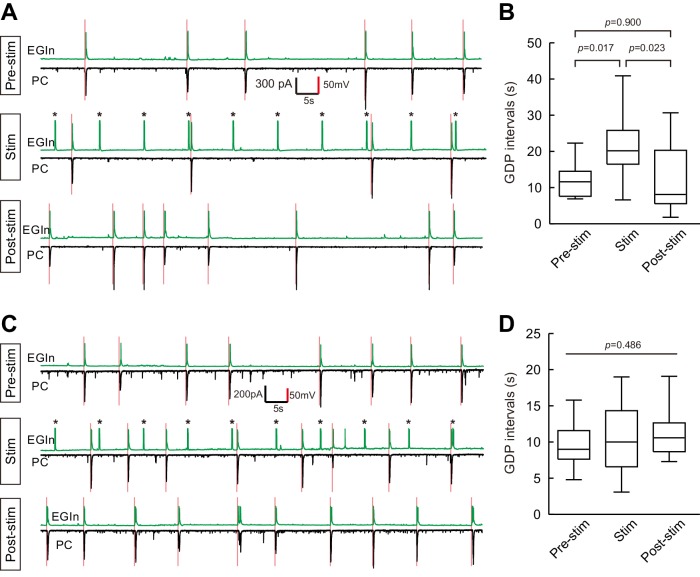
Samples of decreasing and unaltered GDP frequency upon EGIn stimulation.(A) Representative traces where stimulation of an EYFP+ EGIn significantly decreased GDP frequency. (B) Quantification of GDP intervals recorded in (A). (C) Representative traces where stimulation of an EYFP+ EGIn did not change GDP frequency. (D) Quantification of GDP intervals recorded in (C). Detailed statistical analysis, detailed data and exact sample numbers are presented in the Figure 5—source data 1.